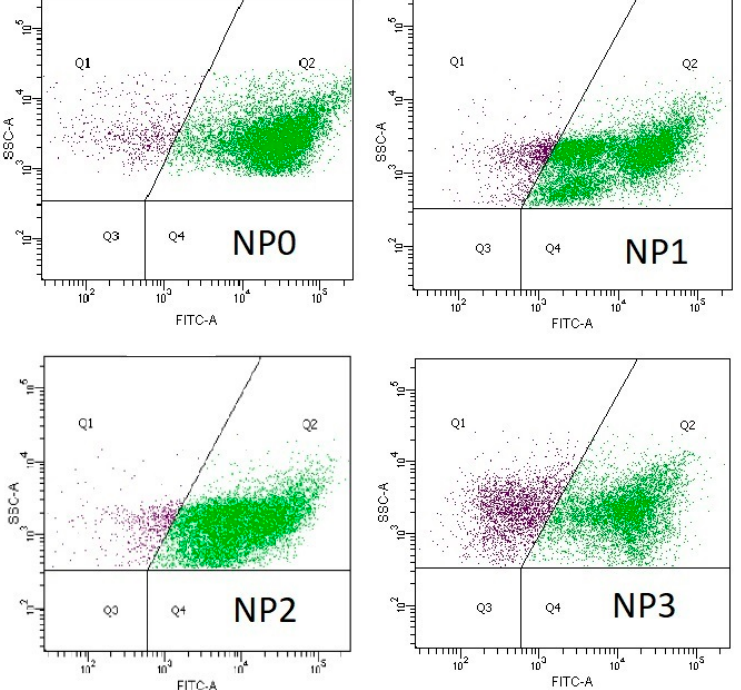
Figure 3. Cytometric analysis of microbial metabolic activity in experimental variants after 168 h of biodegradation. The metabolically active population (Q2) is marked in green, the metabolically inactive population (Q1) is marked in purple.